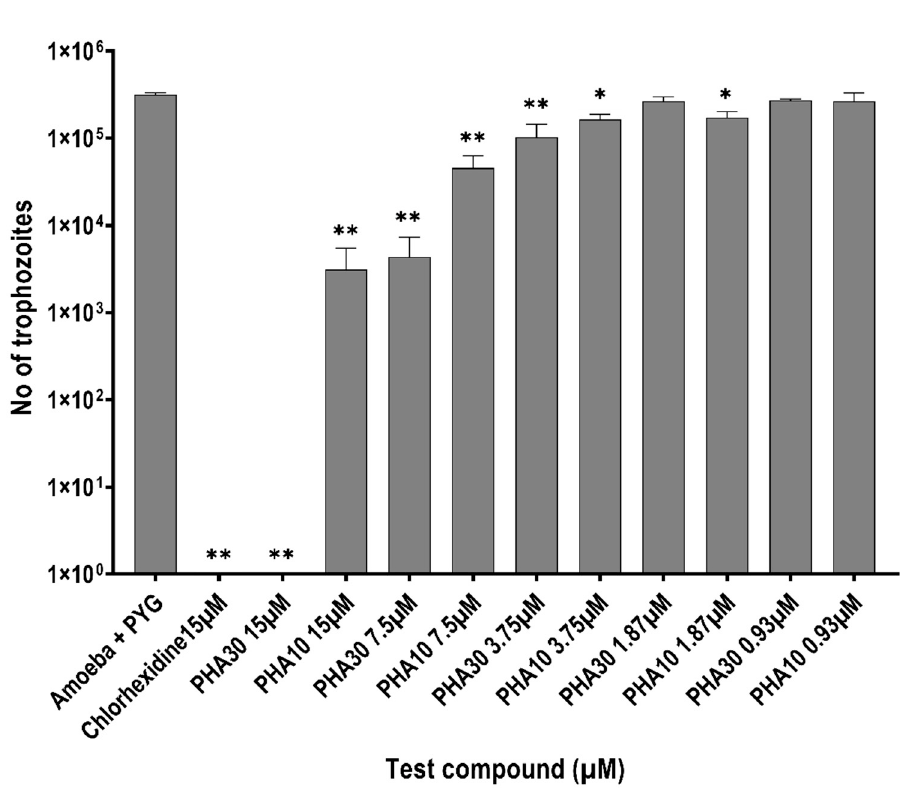
Figure 4. Inhibition of trophozoites re-emergence from cysts by polyhomoarginine (PHA) against A. castellanii ATCC30868. In brief, 5 × 10 5 A. castellanii cysts were incubated with PHA peptides and chlorhexidine at 30 °C for 72 h after which trophozoites were determined by counting on a Neubauer haemocytometer. The results show significant anti-acanthamoeba activity when compared to the amoeba + PYG medium (** p <0.001, * p < 0.05 using a two-sample t -test and two-tailed distribution).